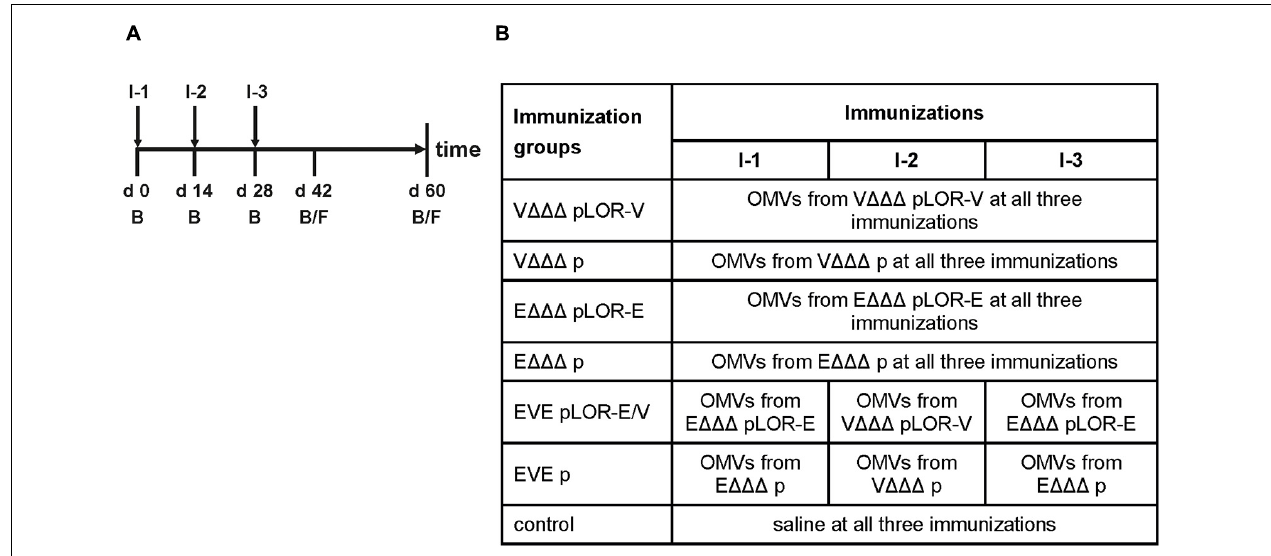
FIGURE 2 | Design of the immunization study. (A) Timeline is given by a horizontal arrow from left to the right. Each vertical bar marks the day of a bleed (B) or fecal pellet (F) collection. Mice received three intranasal immunizations starting with the initial immunization on day 0, followed by boosts on days 14 and 28. Immunizations are indicated by I-1, I-2, and I-3 and are highlighted by vertical arrows. (B) The study comprised seven different immunization groups ( n = 7 for each group) being named after the donor strains of the OMVs used for immunization, i.e., V (cid:49)(cid:49)(cid:49) pLOR-V, V (cid:49)(cid:49)(cid:49) p, E (cid:49)(cid:49)(cid:49) pLOR-E, E (cid:49)(cid:49)(cid:49) p, EVE pLOR-E/V, and EVE p. Immunization groups V (cid:49)(cid:49)(cid:49) pLOR-V, V (cid:49)(cid:49)(cid:49) p, E (cid:49)(cid:49)(cid:49) pLOR-E, or E (cid:49)(cid:49)(cid:49) p received the OMVs of the respective donor strain in all three immunizations (I-1 to I-3). The immunization groups EVE pLOR-E/V and EVE p were immunized with alternating regimen and received OMVs from E (cid:49)(cid:49)(cid:49) pLOR-E or E (cid:49)(cid:49)(cid:49) p on days 0 (I-1) and 28 (I-3) as well as OMVs from V (cid:49)(cid:49)(cid:49) pLOR-V or V (cid:49)(cid:49)(cid:49) p on day 14 (I-2). A sham-immunized group receiving saline at days 0, 14, and 28 served as